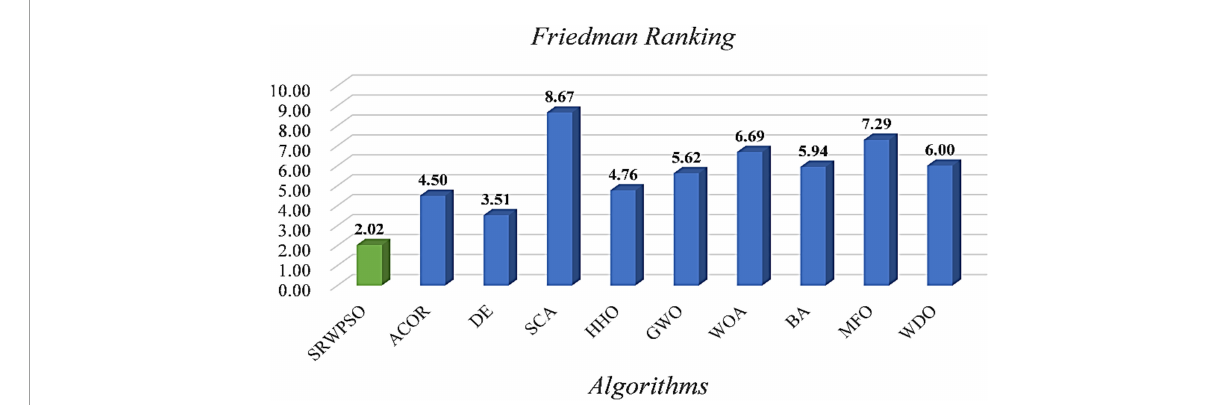
FIGURE7 The results of Friedman test of SRWPSO with traditional algorithms.